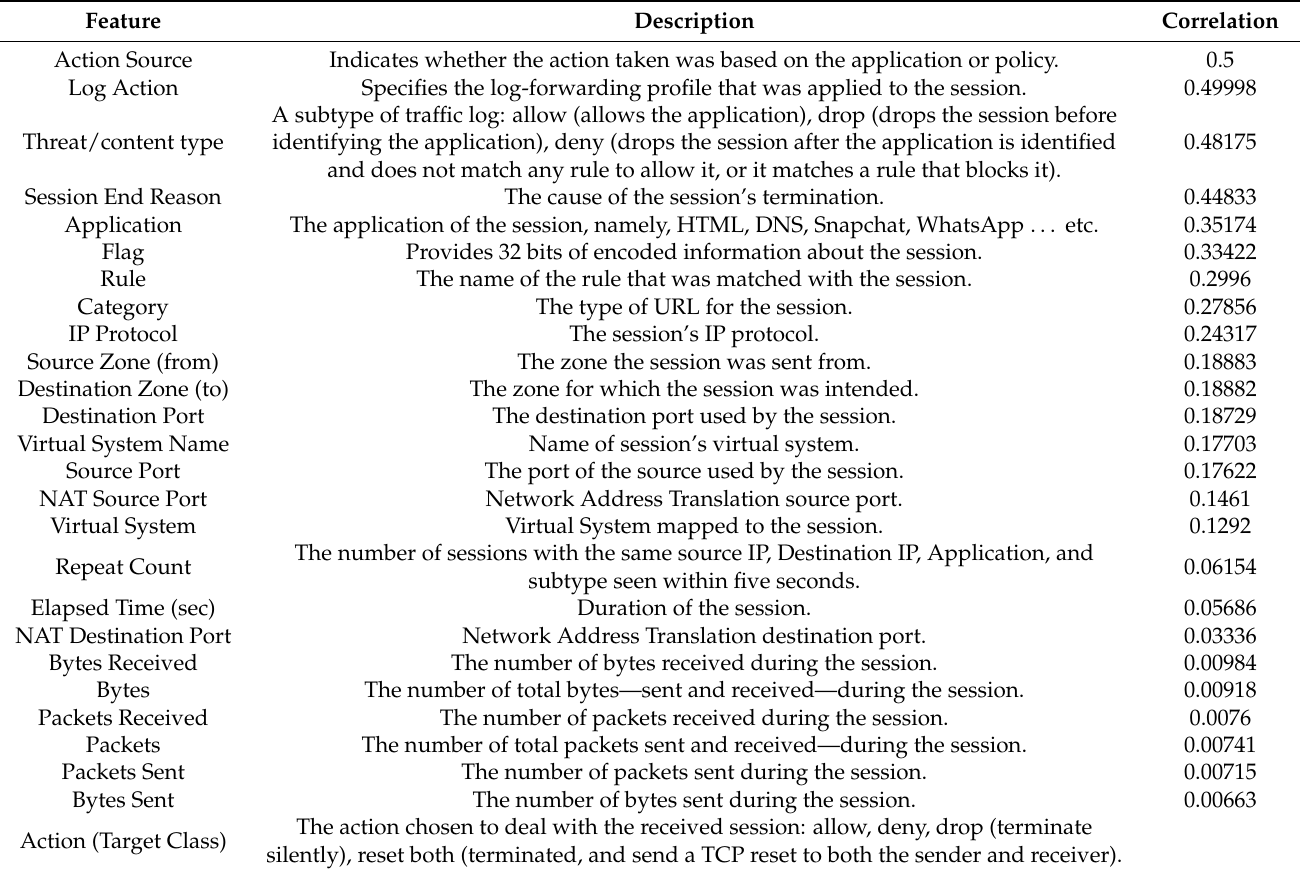
Table 4. Dataset features description and their